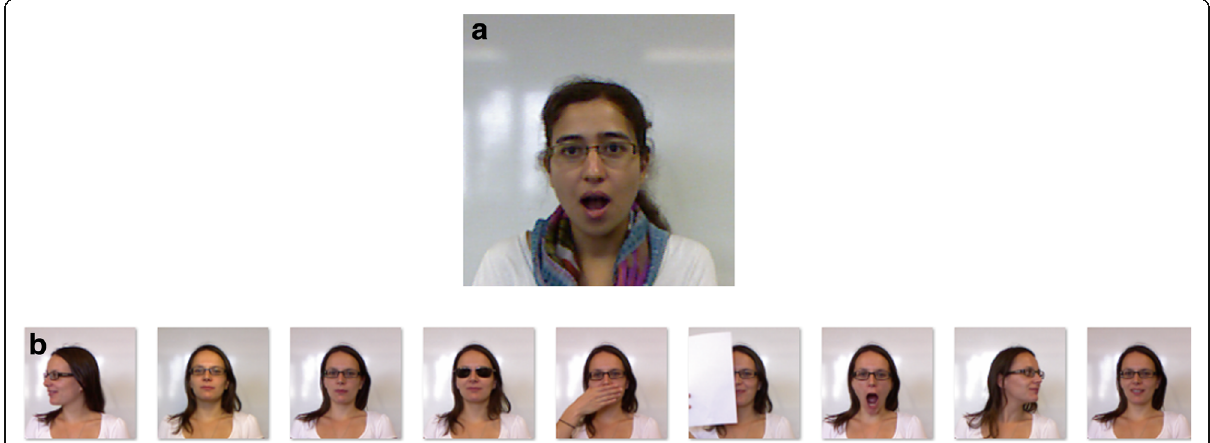
Fig. 5 Example case to show the significance of B-DCNN over DCNN. a Image “ rgb_0031_s2_OpenMouth ” from EKFD incorrectly classified by DCNN however correctly classified by the proposed B-DCNN. b Samples of incorrectly predicted class by the